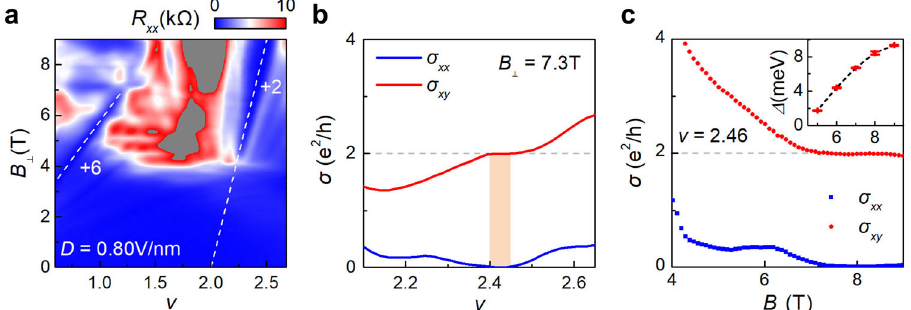
Fig. 3 Valley polarized Chern insulator in CB. a Longitudinal resistance R xx as a function of fi lling factor v and perpendicular magnetic fi eld B ⊥ at D = 0.8 V/nm in device D2. White dash lines correspond to the LL with v LL = + 6 emanating from v = 0 and the C = 2 Chern insulator emanating from v = 2, respectively. b Line cuts of σ ( v , B ⊥ ) at B ⊥ = 7.3 T. The plateau within the orange color area indicates a well-quantized Chern insulator with σ xx = 0 and σ xy = 2 e 2 / h . c Line cuts of σ ( v , B ⊥ ) at v = 2.46. Inset, thermal activation gaps of the Chern insulator versus perpendicular magnetic fi eld. Error bars are estimated according to the uncertainty at the thermal activation